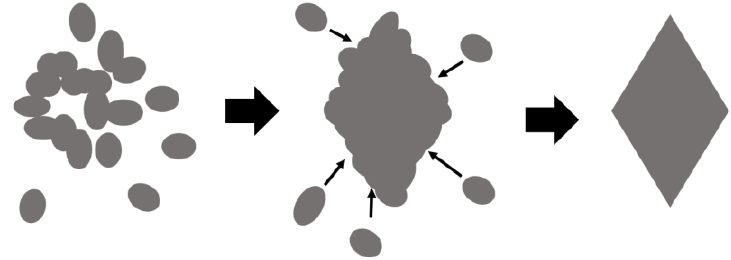
Figure 4. Morphological evolution of as-prepared Mn 3 O 4 catalysts.